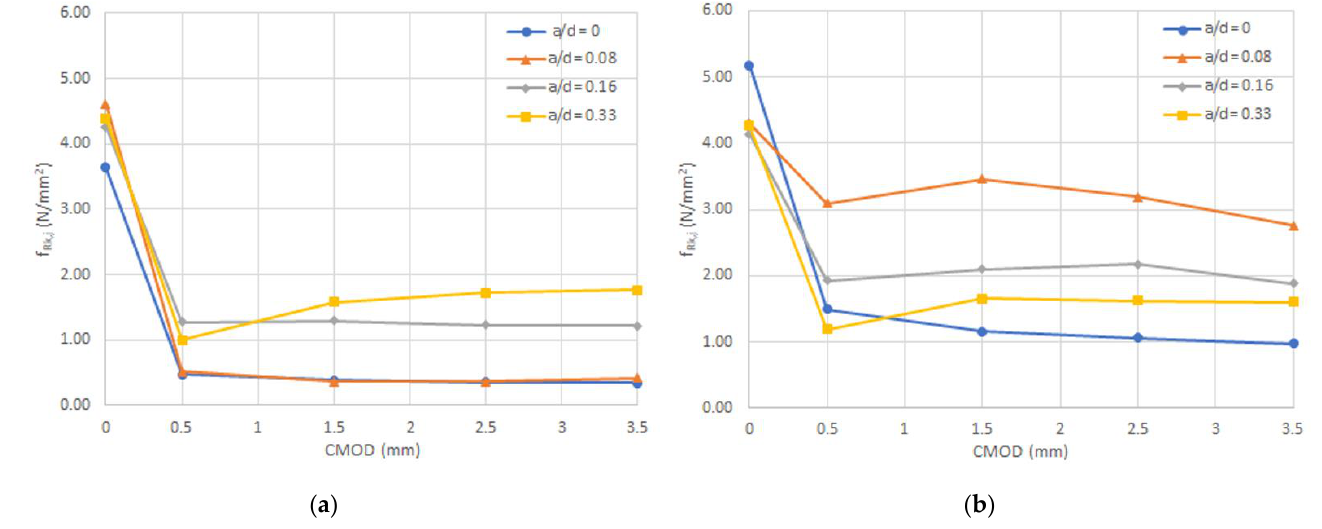
Figure 10. Characteristic residual strength for each (a/d) ratio: ( a ) Series 1 and ( b ) Series 2. Table 4. Classification of the residual stress for Series 1 and